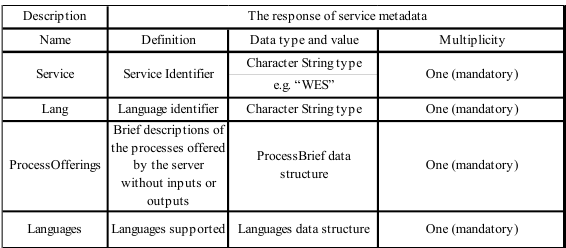
Table 2. The response of WES GetCapabilities .